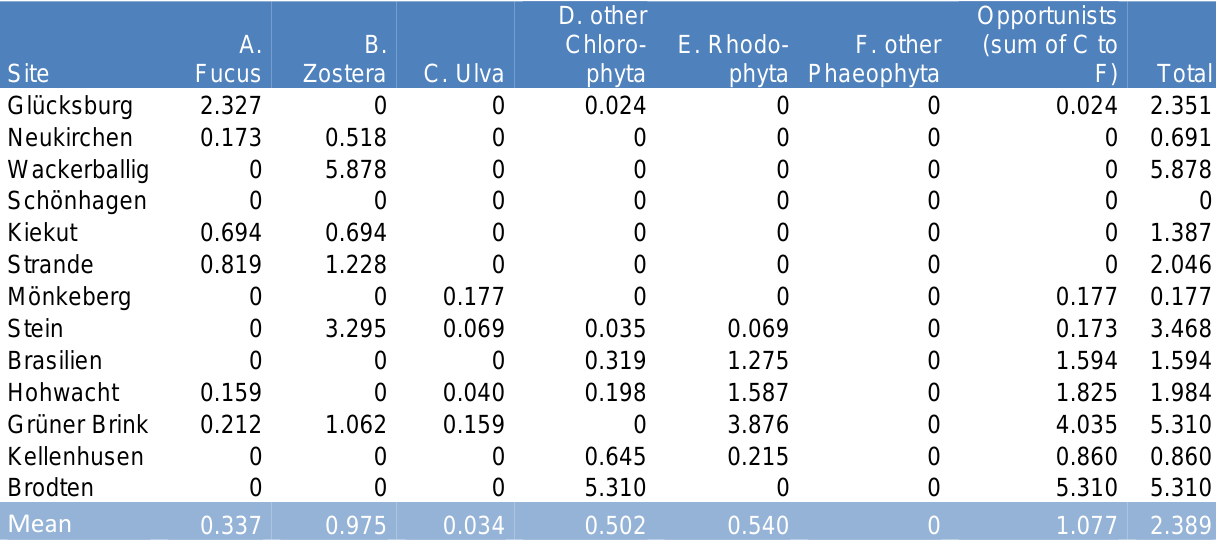
Table S2A: Dry matter of different macrophytes in beach wrack sampled in August/September 2013, related to length of beach line [kg m -1 ]